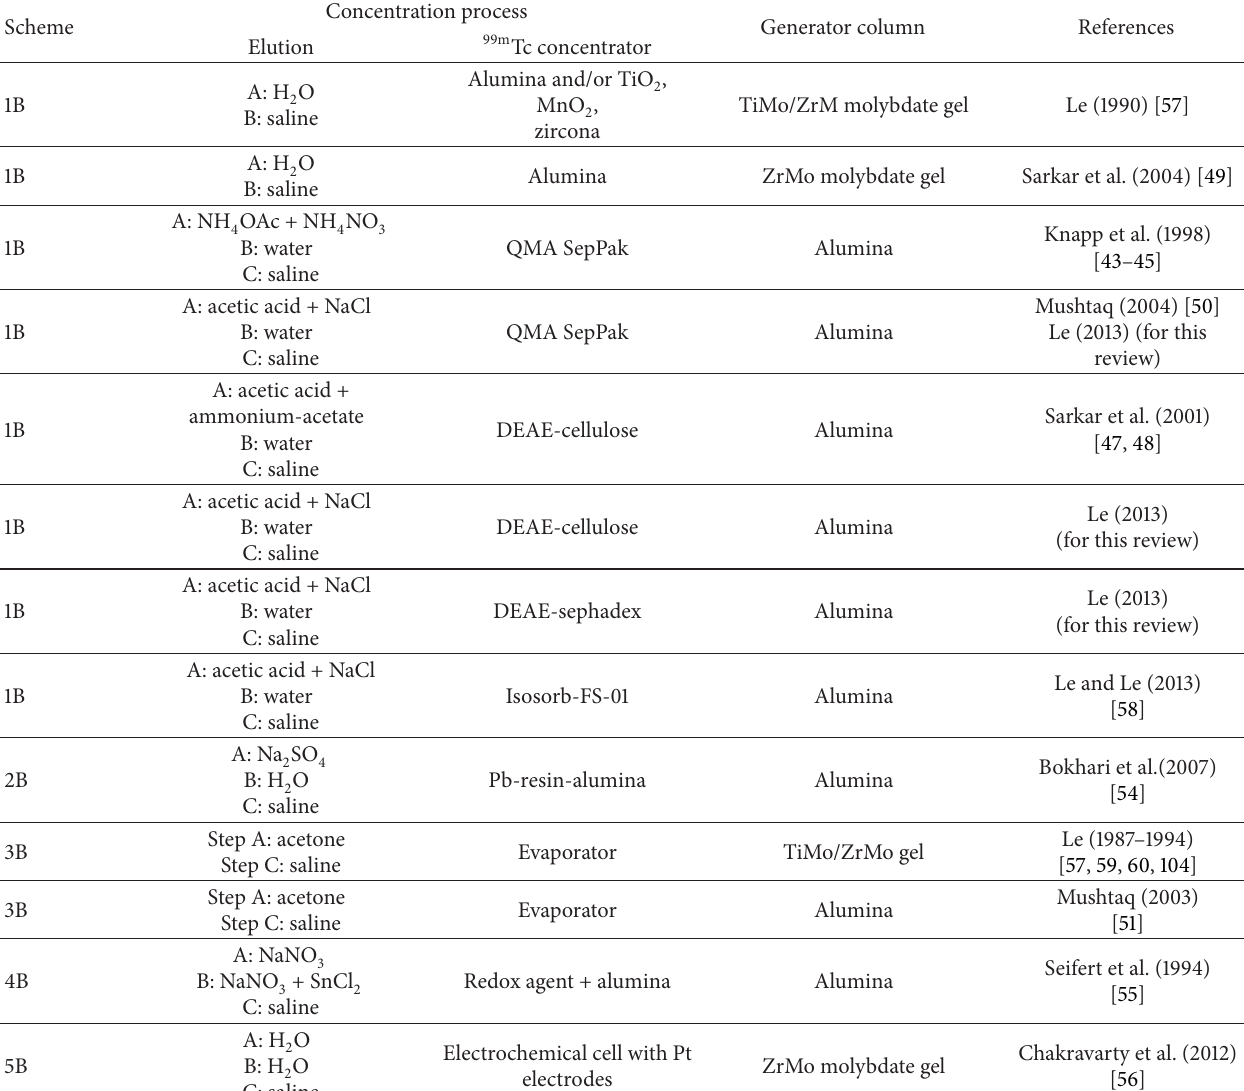
Table 5: Details of methods of 99m Tc-pertechnetate concentration from the nonsaline eluate of 99m Tc-pertechnetate (single and dual column concentration